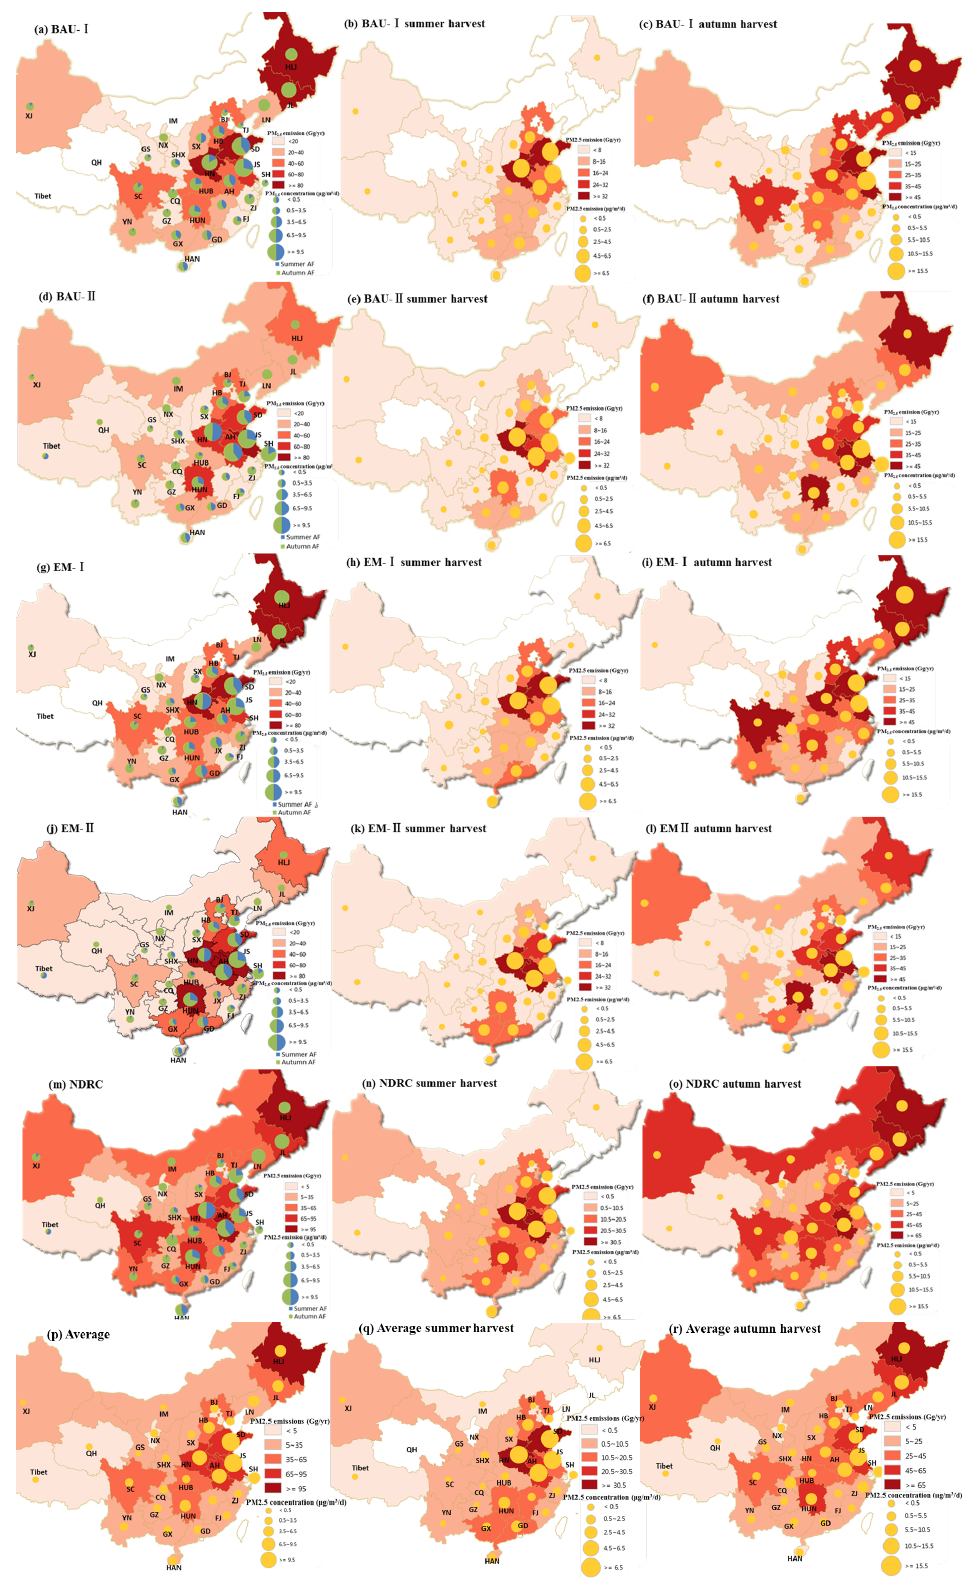
Figure 7. Spatial and temporal distribution of smoke PM 2 . 5 emissions and flux concentrations from agricultural field burning over China in